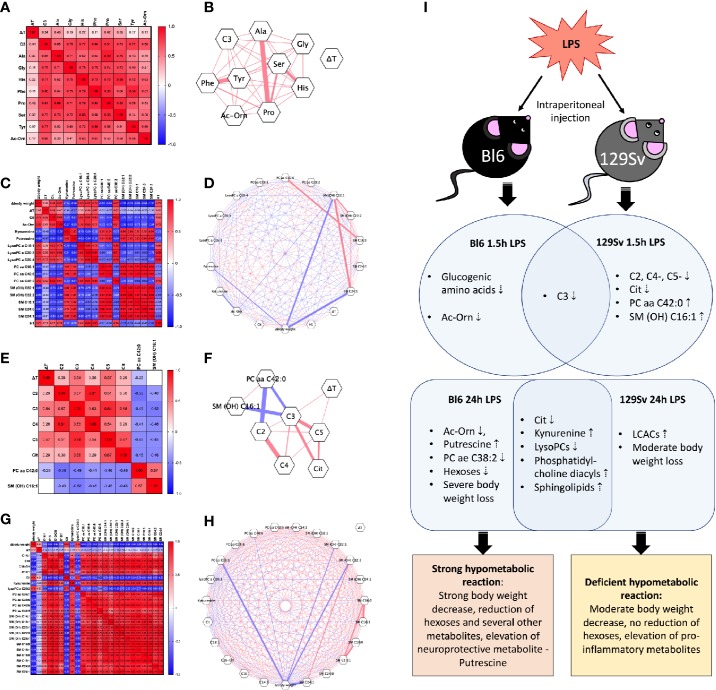
Heat-map of Pearson correlation coefficients between body weight change (Δbody weight), temperature change (ΔT), and all significantly altered metabolites (Log10) in (A) Bl6 1.5 h LPS challenge, (C) Bl6 24 h LPS challenge, (E) 129Sv 1.5 h LPS challenge, and (G) 129Sv 24 h LPS challenge. Significant correlations (p < 0.05) are highlighted by correlation network diagram in (B) Bl6 1.5 h LPS challenge, (D) Bl6 24 h LPS challenge, (F) 129Sv 1.5 h LPS challenge, and (H) 129Sv 24 h LPS challenge. Red lines represent positive and blue lines negative correlations: the strength of the correlation is indicated by line thickness. (I) Biomarkers of inflammation 1.5 and 24 h after LPS administration in Bl6 and 129Sv. Data represented in the illustration is derived from the GLM model.